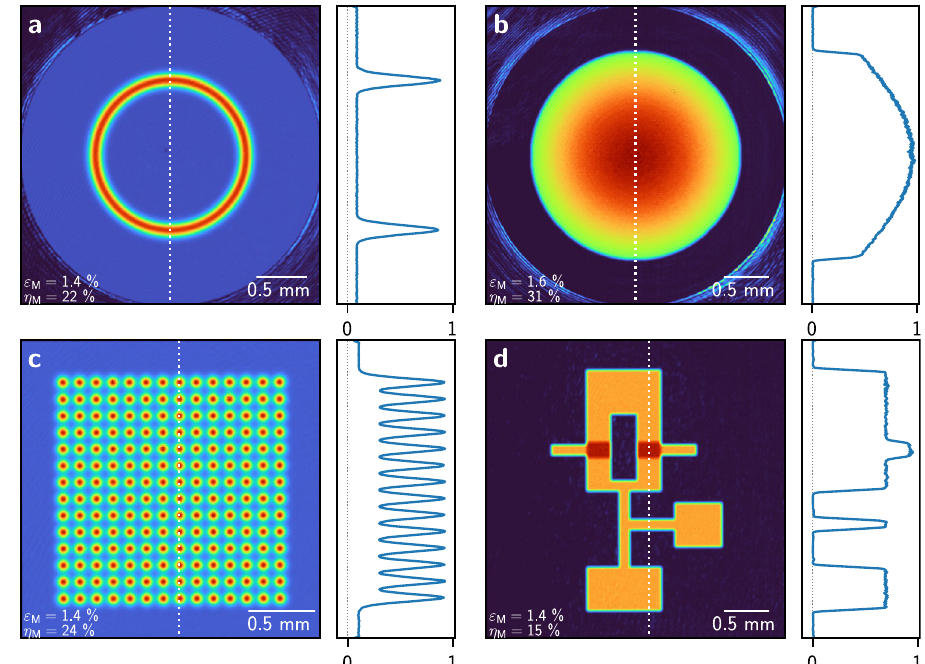
Figure 5. Camera images and their normalised profiles (along the white dashed lines) after 15 feedback iterations using the FFT with the crosstalk model. ( a ) Ring with a Gaussian profile on a non-zero background. ( b ) Gaussian potential with offset. ( c ) Gaussian spot array on a non-zero background. ( d ) An ‘atomtronic’ logical OR gate 17